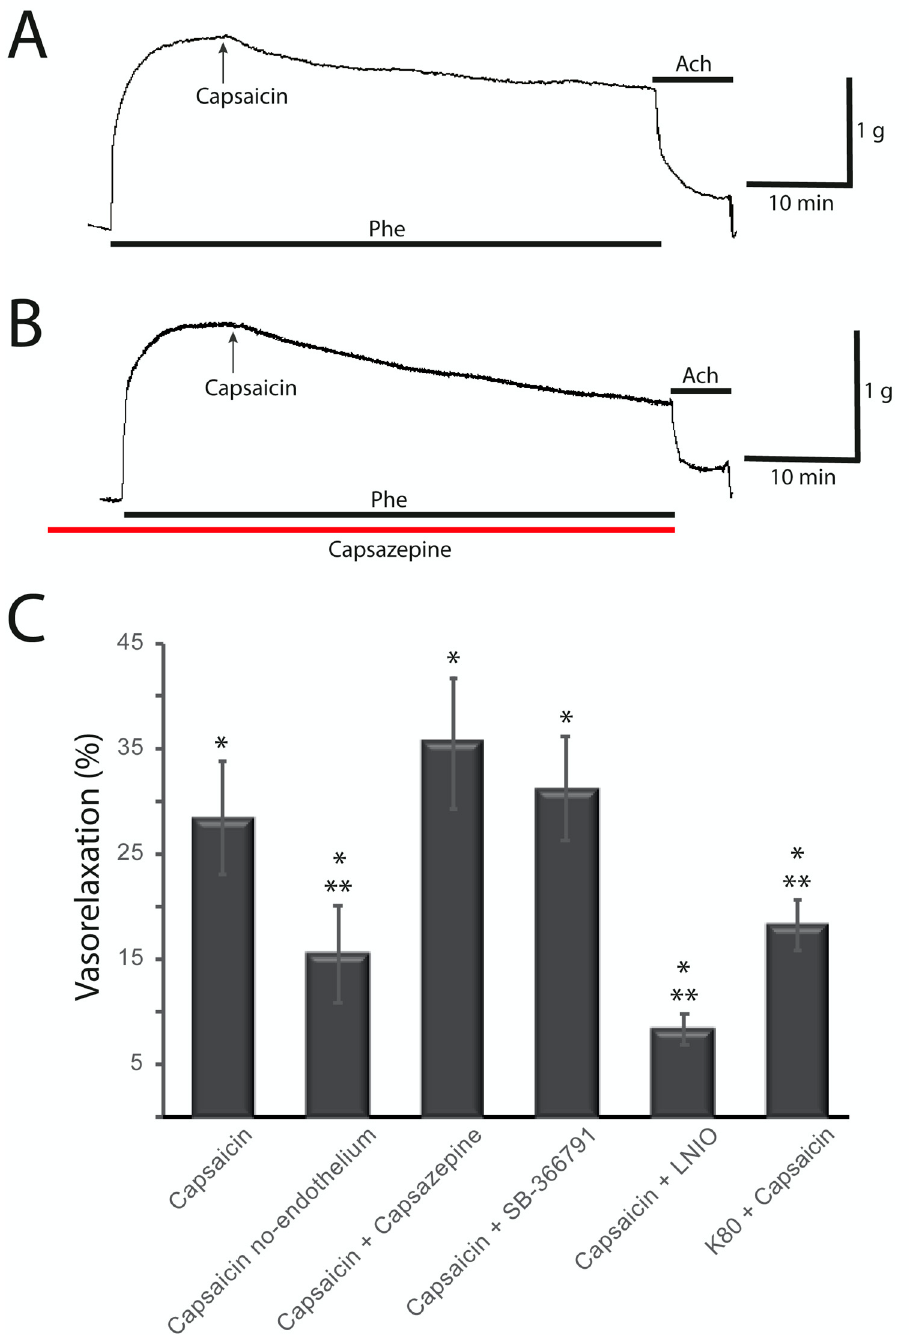
Figure 3. Vasorelaxant effect induced by Capsaicin 10 µM. ( A ) Typical recording showing the vasorelaxant response to Capsaicin in a pre-contracted rat aortic ring with endothelium. Black arrows indicate the addition of Capsaicin. The TRPV1 agonist Capsaicin 10 µM causes a vasorelaxant effect of 28.33 ± 5.41% (relative to Phe pre-contraction; p < 0.01; n = 20 rings, 10 rats). ( B ) Representative trace showing that Capsazepine 10 µM does not antagonize the vasorelaxant effect observed with Capsaicin (35.63 ± 6.32%; p < 0.01; n = 9 rings, 7 rats). The red line indicates the addition of Capsazepine. ( C ) Summary of the effect induced by Capsaicin under different experimental conditions. * indicates a significant change in tension compared to Phe pre-contraction. ** indicates a significant change compared to the effect of Capsaicin alone.